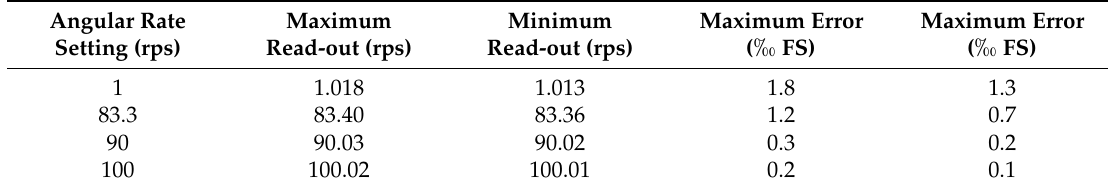
Table 1. Measurement errors of the magnetic induction sensor.